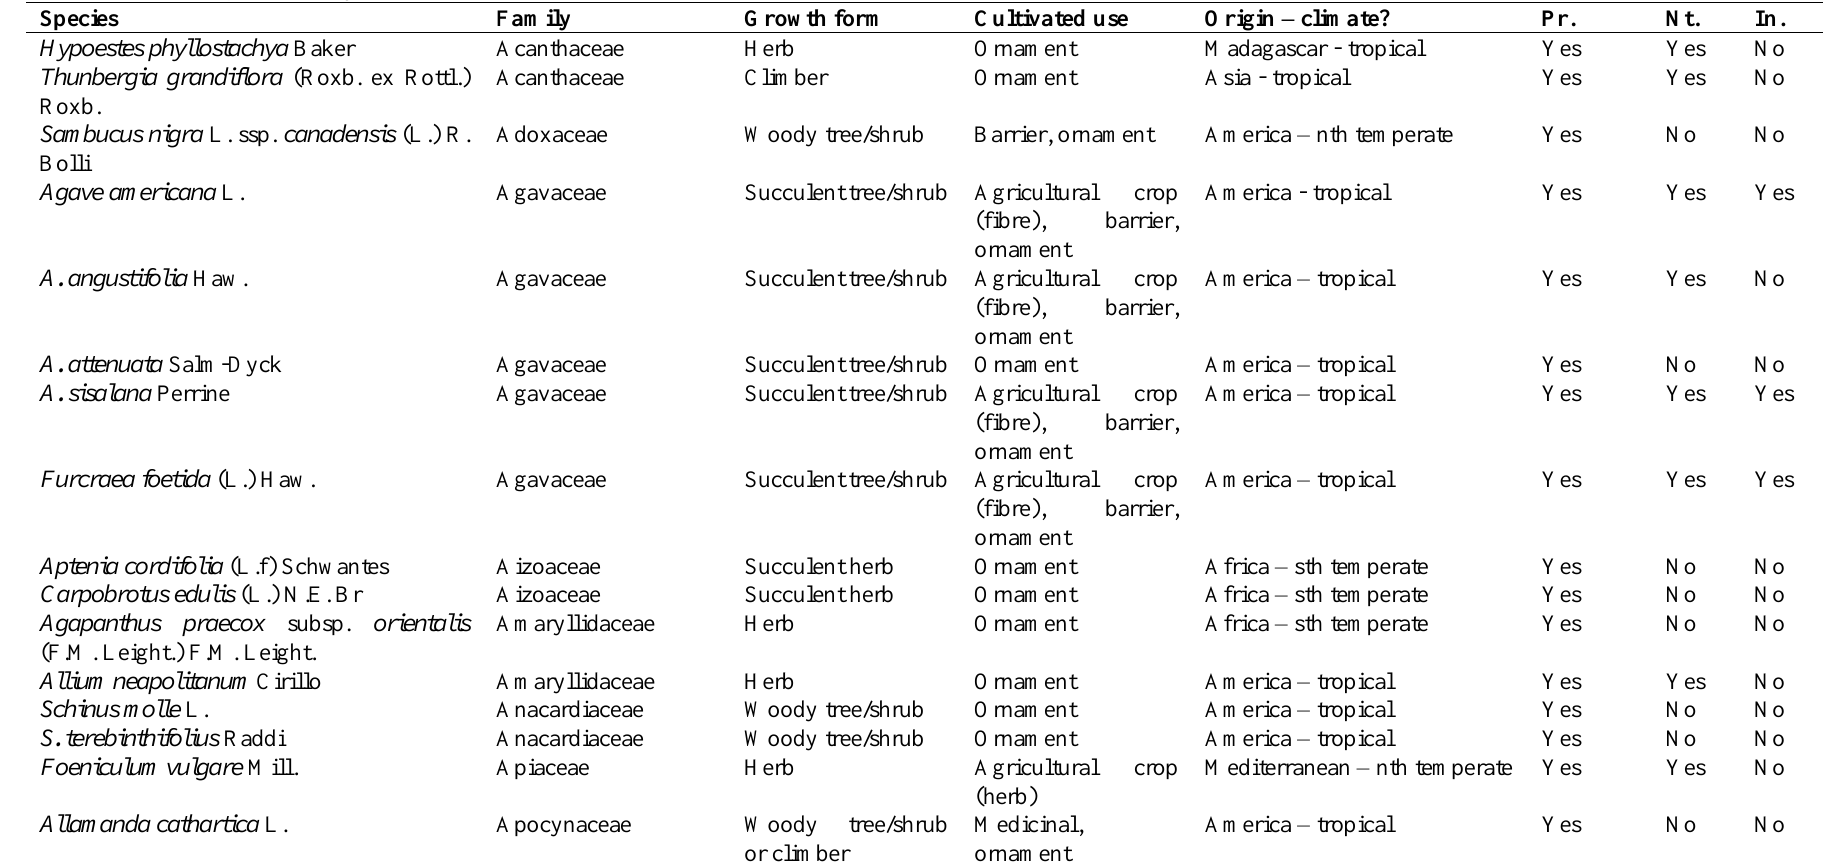
TABLE 1–A1: Status (Pr.-present; Nt.-naturalised; In.-invasive) of exotic species recorded during surveys in Laikipia County, most of which were probably intentionally introduced (since they are used in cultivation), and that are also known to be naturalised or invasive elsewhere (outside of Laikipia